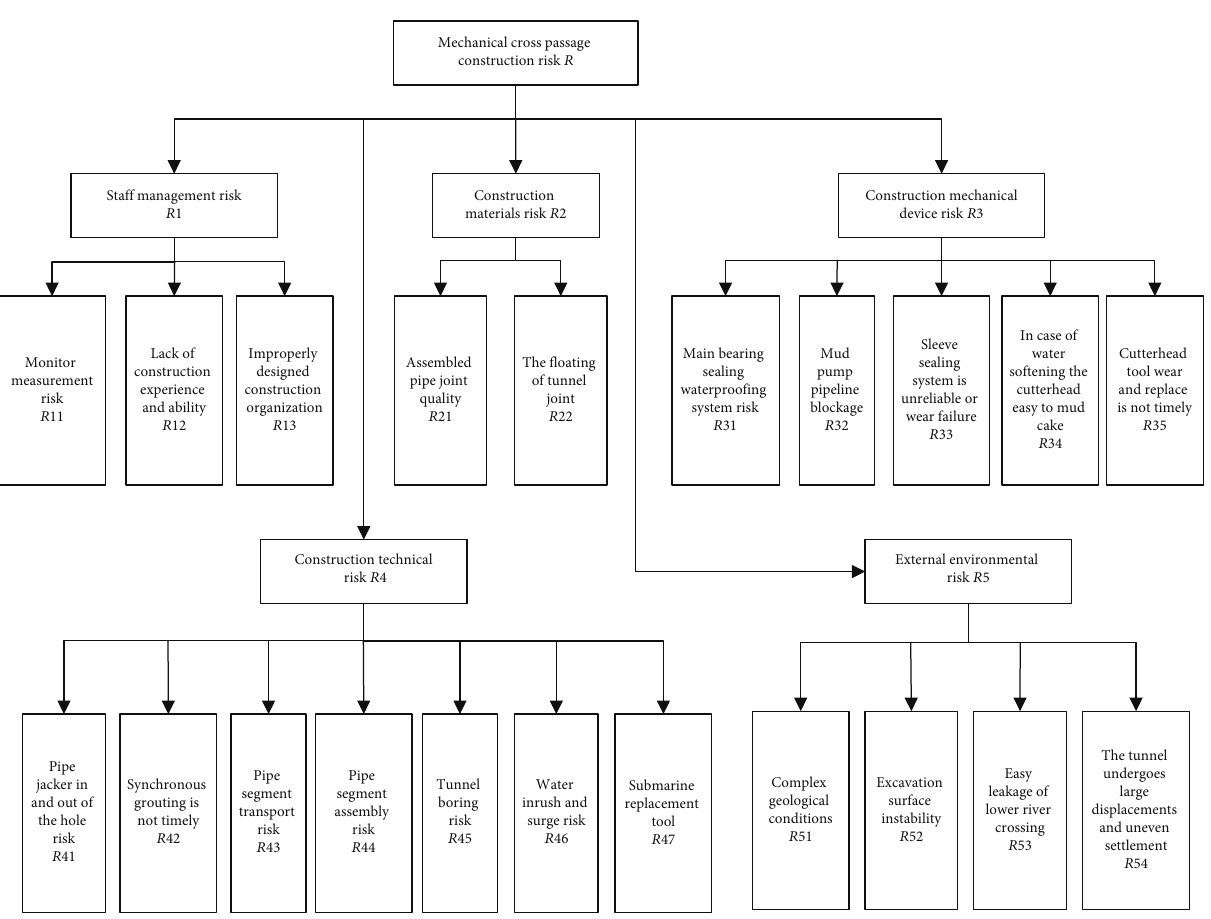
Figure 6: Connecting aisle location risk